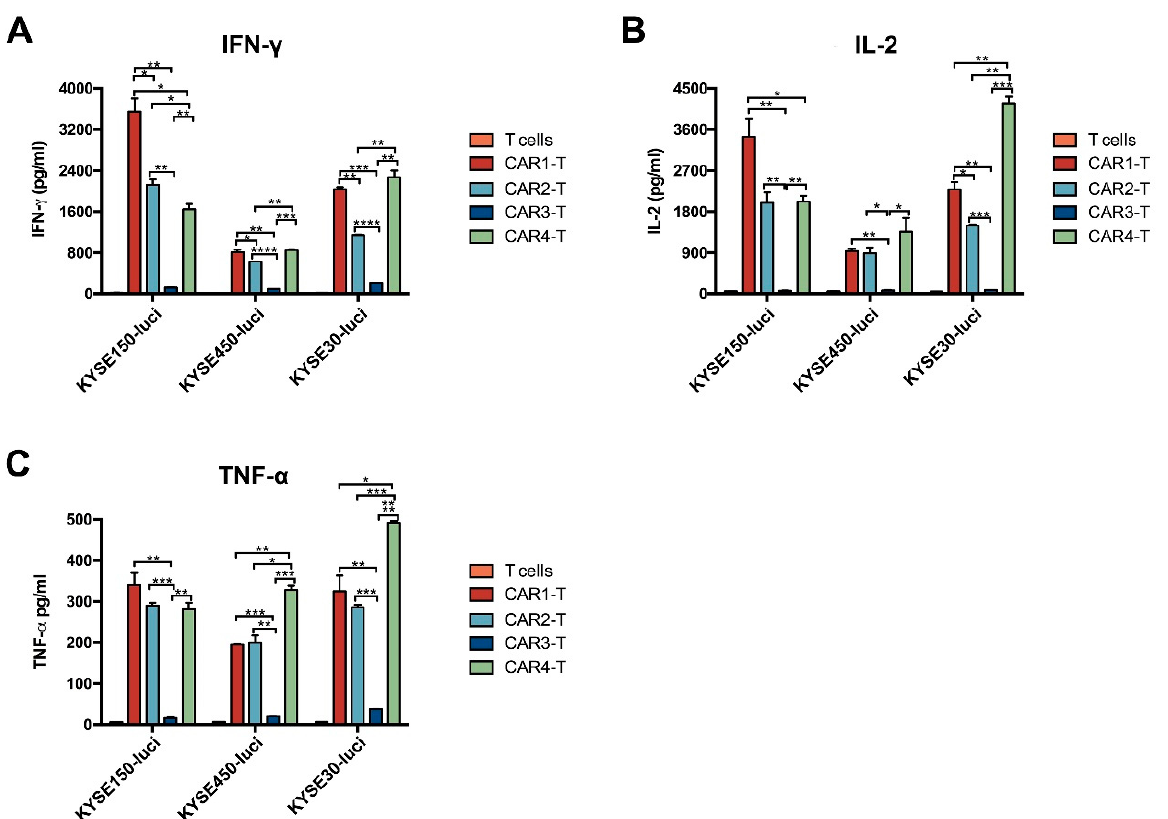
Figure 5. Secretion of IFN- γ , IL-2, and TNF- α by anti-EGFR CAR-T cells. Anti-EGFR CAR-T cells were incubated with KYSE450, KYSE150, and KYSE30 cells for 3 days, and culture supernatants were analyzed for the concentrations of ( A ) IFN- γ , ( B ) IL-2, and ( C ) TNF- α . Unpaired multiple two-tailed t -test, * p < 0.05, ** p < 0.01, *** p < 0.001, and **** p < 0.0001. EGFR, epidermal growth factor receptor; IFN- γ , interferon γ ; IL-2, interleukin 2; TNF- α , tumor necrosis factor α .